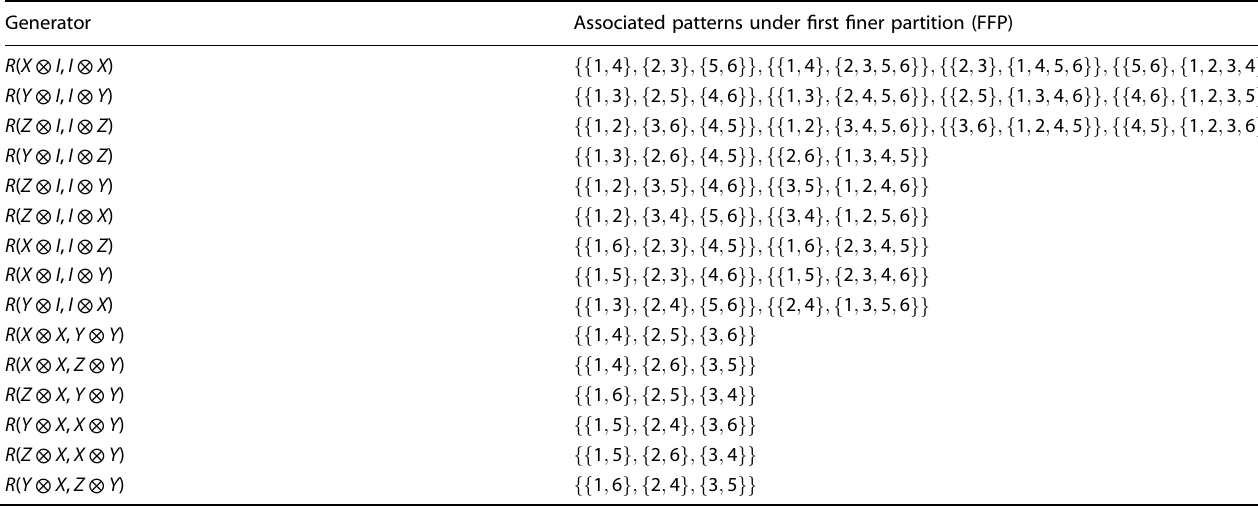
Table 1. The elements of S and the explicit row patterns they are associated with under FFP. Generator Associated patterns under fi rst fi ner partition (FFP)